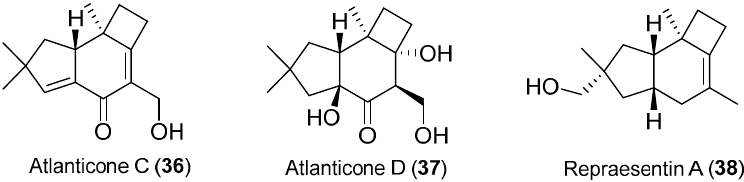
Figure 8. Structures of protoilludanes 34 – 38 isolated from the Lactarius genus of fungi.